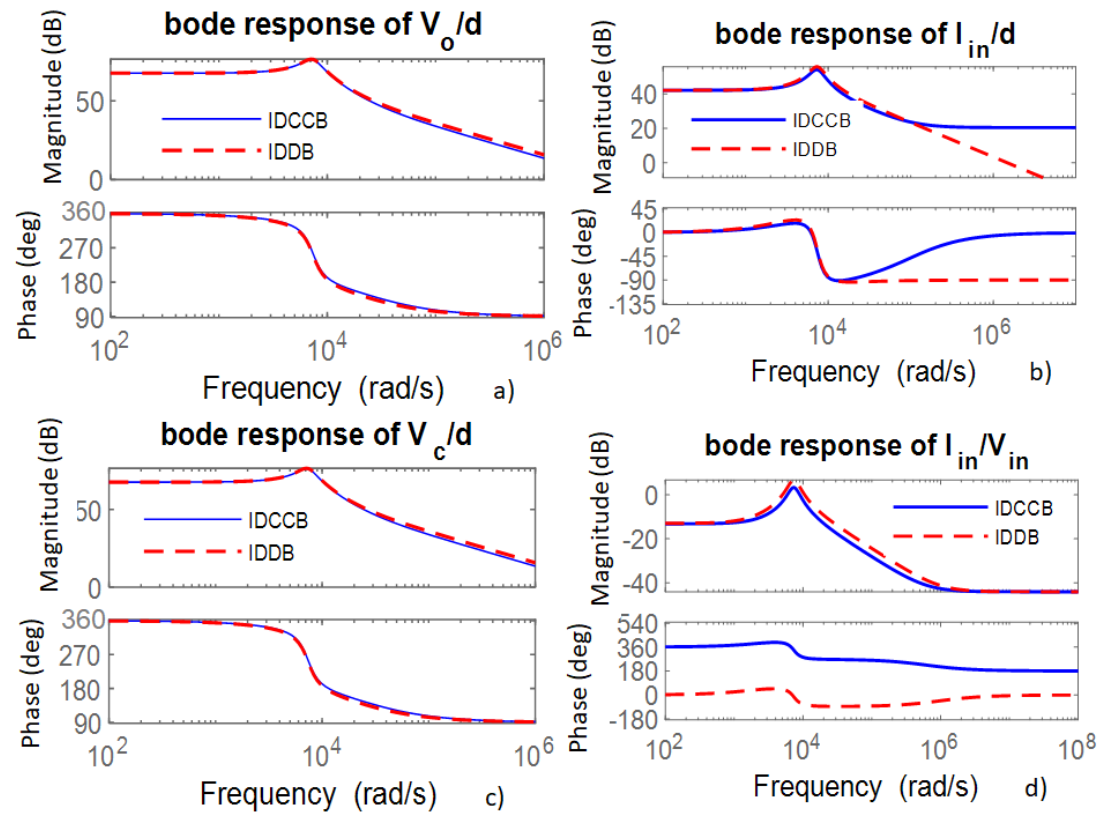
Figure 9. Bode plots: ( a ) output voltage-to-duty ratio ( V o /d ); ( b ) input current-to-duty ratio ( I in /d ); ( c ) capacitor voltage-to-duty ratio ( V c /d ); ( d ) input current-to-input voltage ( I in / V in ) transfer functions for the